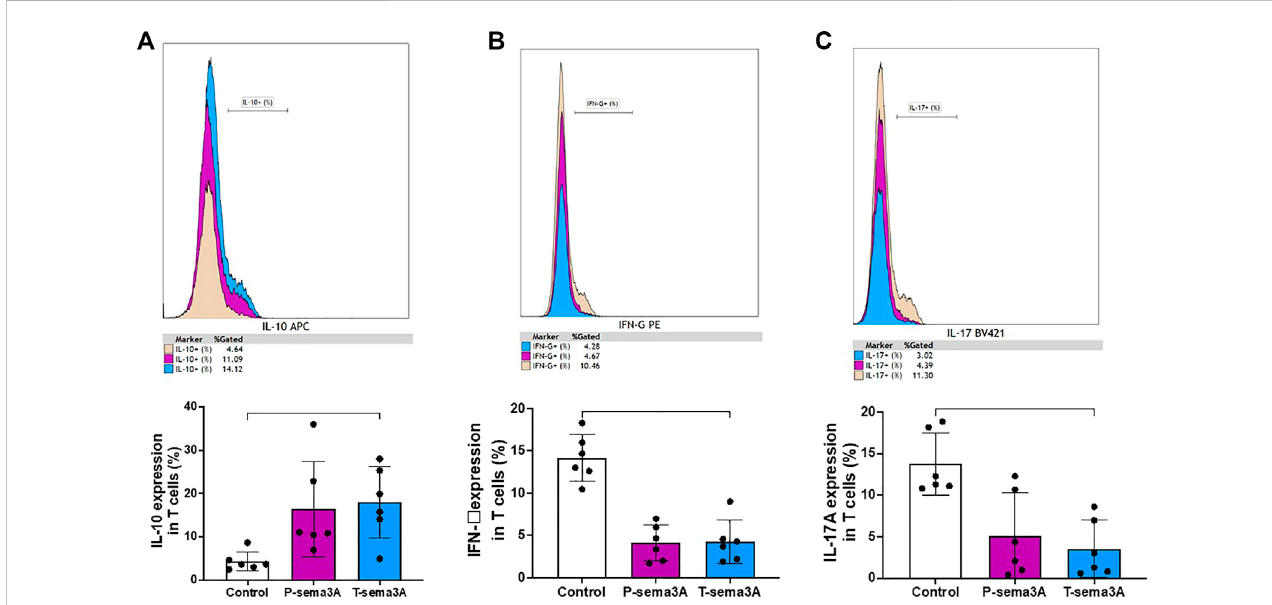
FIGURE 5 Truncated sema3A induces regulatory pattern in CD3+T lymphocytes. Primary CD3+T cells were isolated from PBMCs using MACS microbeads and MS column. The cells were cultured in 12-well plates, pre-coated with 10 μ g/mL anti-CD3 for 4 h at 37 ° C, in addition to 1 μ g/mL anti-CD28, for 24 h at 37 ° C. After24 h,1 μ g/mLofP-orT-sema3Aoranappropriateamountofacontrolelutionbufferwasaddedforanextra24 hat37 ° C.Onthedayoftheexperiment, cellswerestainedwith fl uorescenceantibodiesandtheexpressionofthefollowingcytokineswasevaluatedinaNAVIOUSEX fl